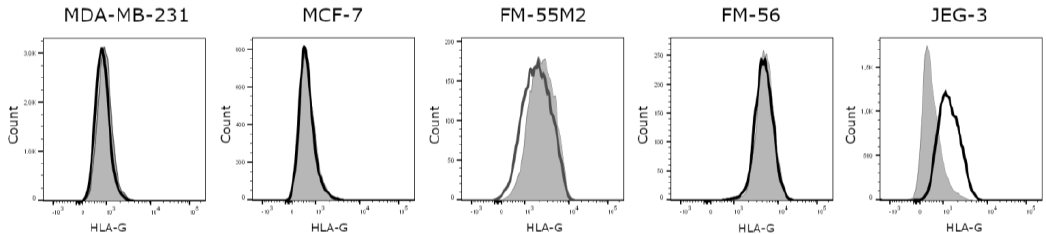
Figure 1. Human leukocyte antigen (HLA)-G surface expression on cancer cell lines. Representative histograms showing the expression of HLA-G on untreated cells compared to an isotype control. MDA-MB-231, MCF-7, FM-55M2, and FM-56 cell lines are HLA-G-negative, whereas JEG-3 cells are HLA-G-positive. Filled grey: Cells stained with isotype antibody as a negative control for HLA-G expression; solid black: Untreated cells stained with anti-HLA-G antibody.